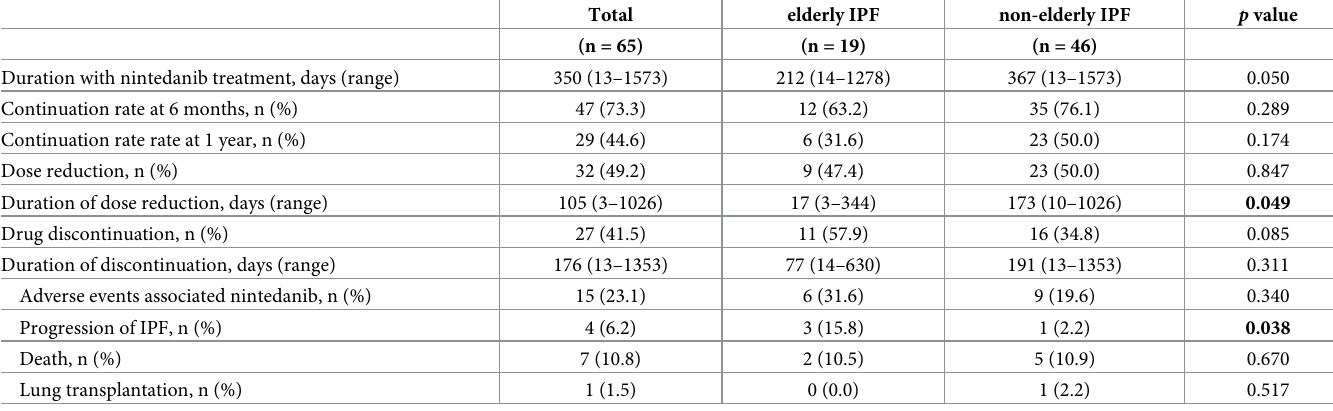
Table 2. Nintedanib